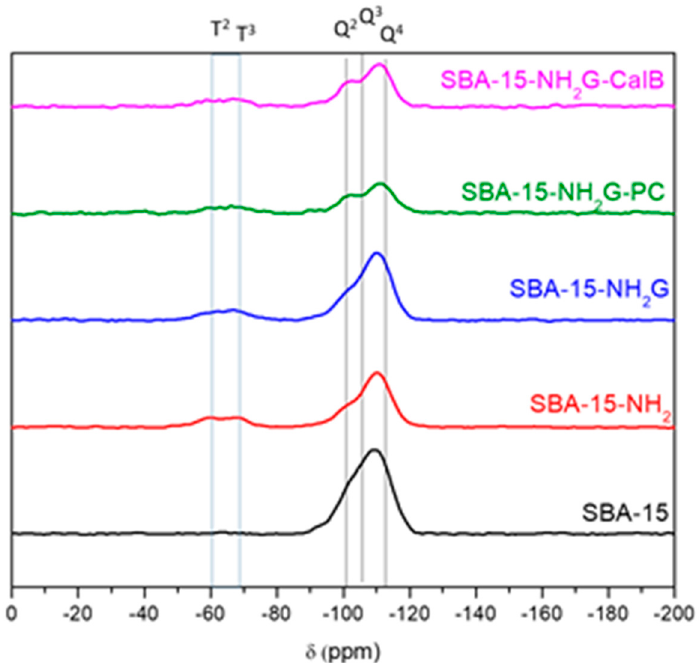
Figure 3. Solid state 29 Si MAS-NMR spectra of the different materials.